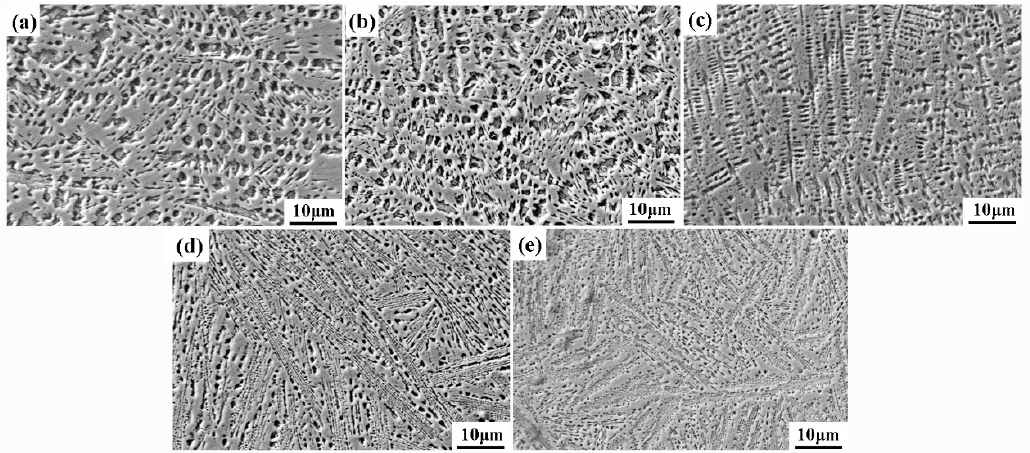
Figure 9. SEM images of the microstructure of units: ( a ) No. 1, ( b ) No. 2, ( c ) No. 3, ( d ) No. 4, and ( e ) No. 5.